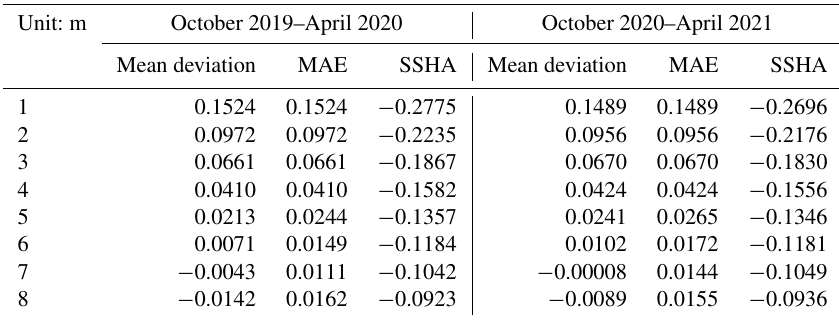
Table 8. Table of differences between CryoSat-2 radar freeboard and HY-2B radar freeboard retrieved by different SSHA determination schemes.